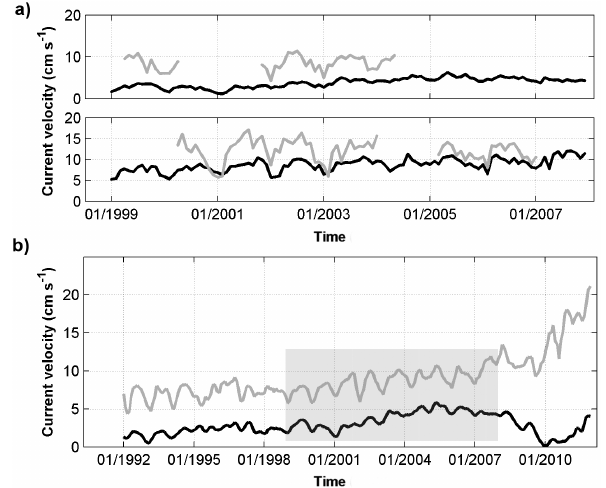
Figure 14. (a) Comparison between monthly time series of current meter (gray) and the ECCO2 (black) velocity (cms − 1 ) at ∼ 3100m based on the M2 position (upper panel) and at ∼ 4580m based on the M3 position (bottom panel; see mooring positions in Fig. 1). (b) Monthly ECCO2 time series of current velocity (cms − 1 ) at the M2 position (black line) and the M3 position (gray line) for the period 1992–2011. Both time series are filtered using a 3-month moving average. The boxes highlight the period shown in (a)